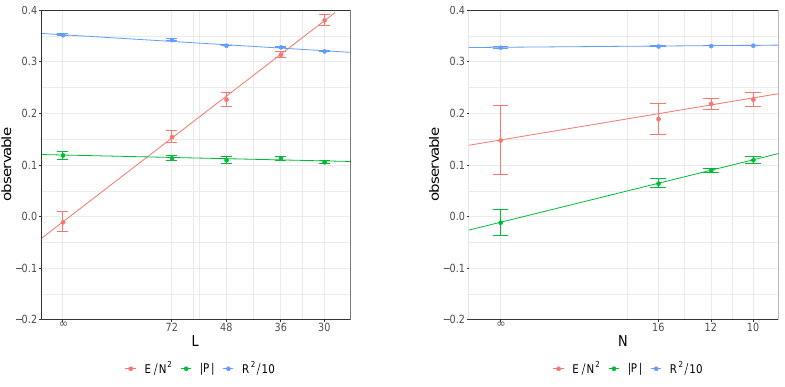
Figure 5. Large N (right) and continuous (left) extrapolations for temperature T = 0 . 2 lead to confinement. Large N extrapolation sets the Polyakov loop to zero while continuous extrapolation sets the energy to zero. R 2 / 10 denotes the normalized sum of all (nine) scalars R 2 =